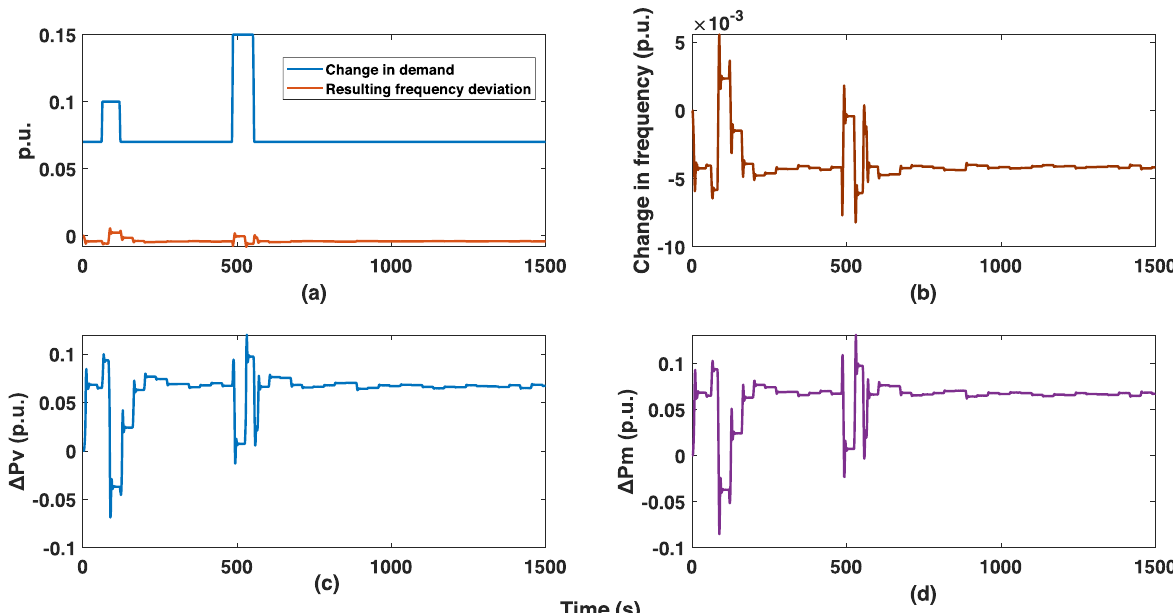
Fig. 5 System response during changes in demand with frequency measurement noise variance of 0.005: a Variation in Δ f; b Frequency response during control action; c Variation of states Δ P v ; d Variation of states Δ P m